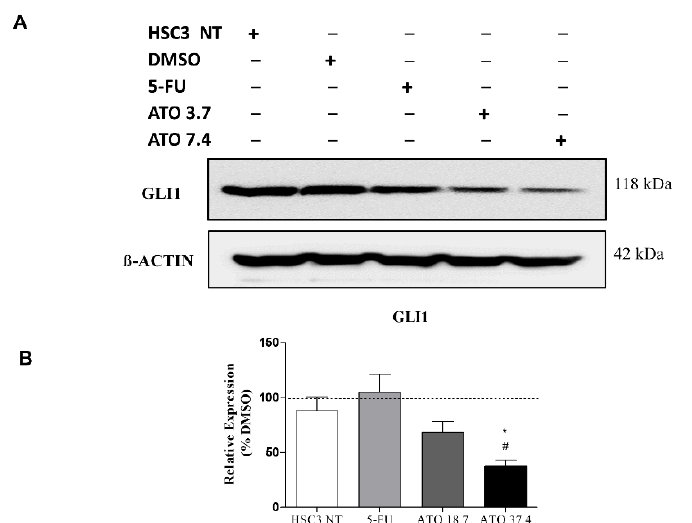
Figure 6. The representative images of GLI1 protein staining (green) in HSC3 cells. Nuclei are in blue. (Scale Bar: 100 µm) ( A ). Graphic representation of Fluorescence Intensity ( B ). Gene expression of GLI1 ( C ). The vehicle was used (0.25% DMSO) as a negative control (CTL) and 5-FU (16.75 µM) was used as a positive control. The Cq value for each sample was normalized using GAPDH as a reference gene, then calibrated according to the Cq values obtained for the untreated HSC3 cell group (HSC3 NT). (*) p ≤ 0.05 when compared to the negative control (CTL), and (#) when compared to the HSC3 NT group (non-treated cells) by ANOVA (analysis of variance) followed by Student Newman-Keuls test.